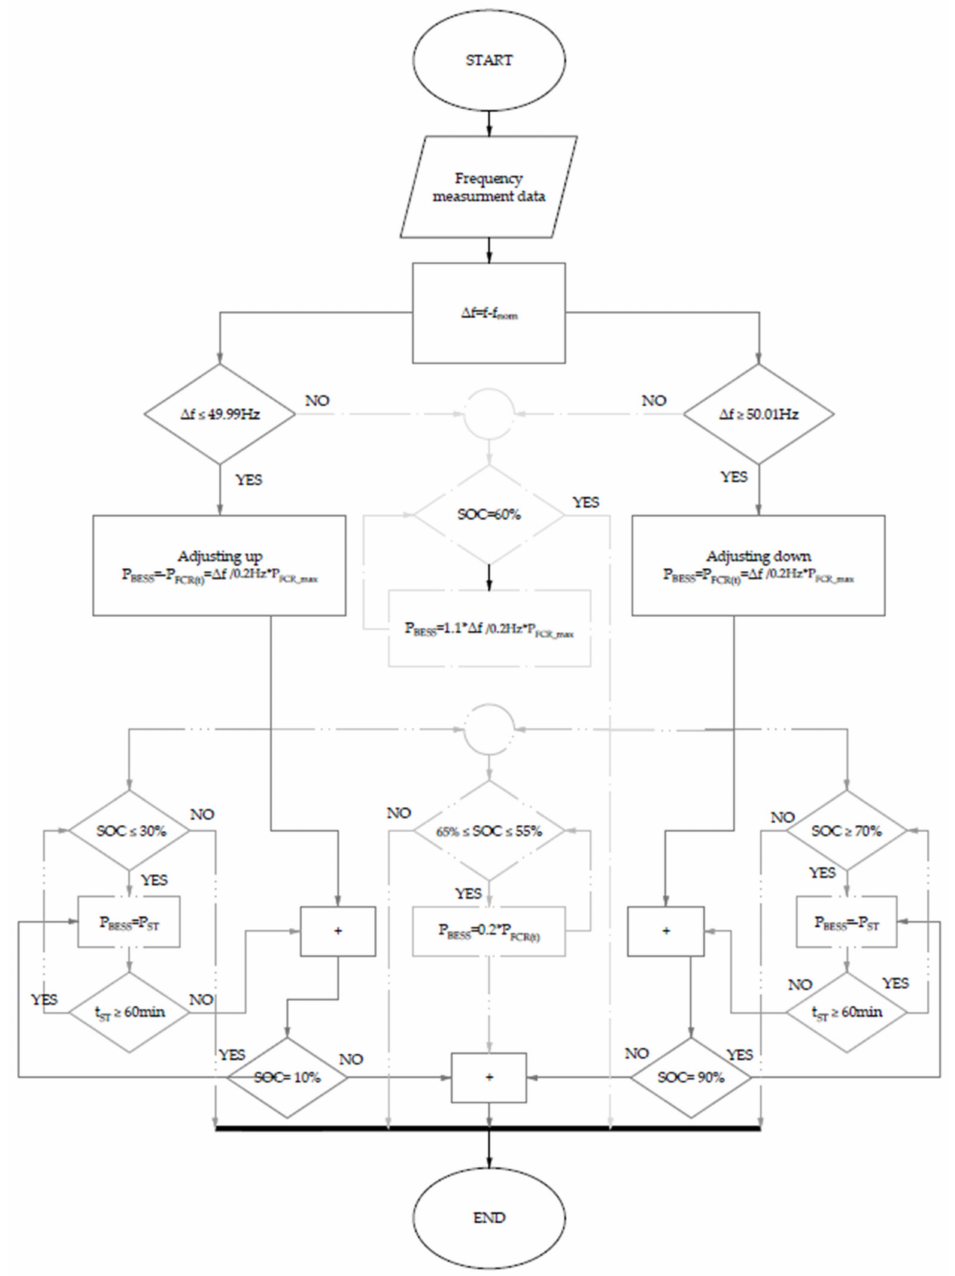
Figure 6. Blocksheme for the BESS